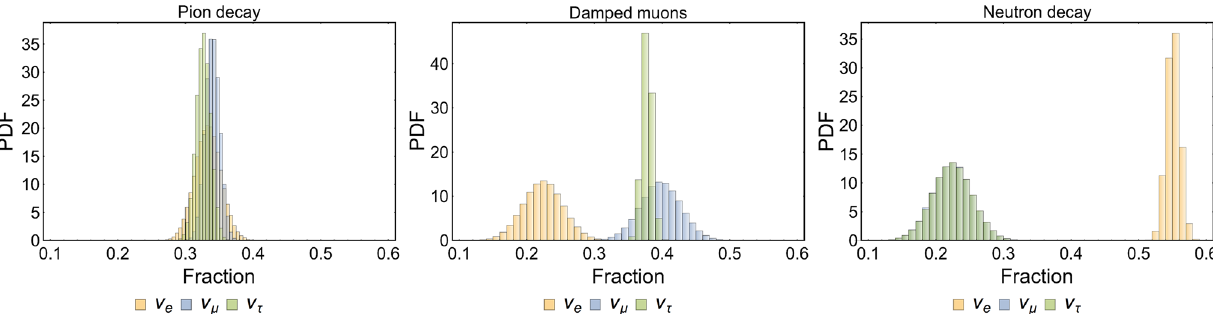
Fig. 1 FlavorcompositionofastrophysicalneutrinosexpectedatEarth after neutrino oscillations, assuming that they are produced by pion decay (left panel), pion decay with damped muons (middle panel) and